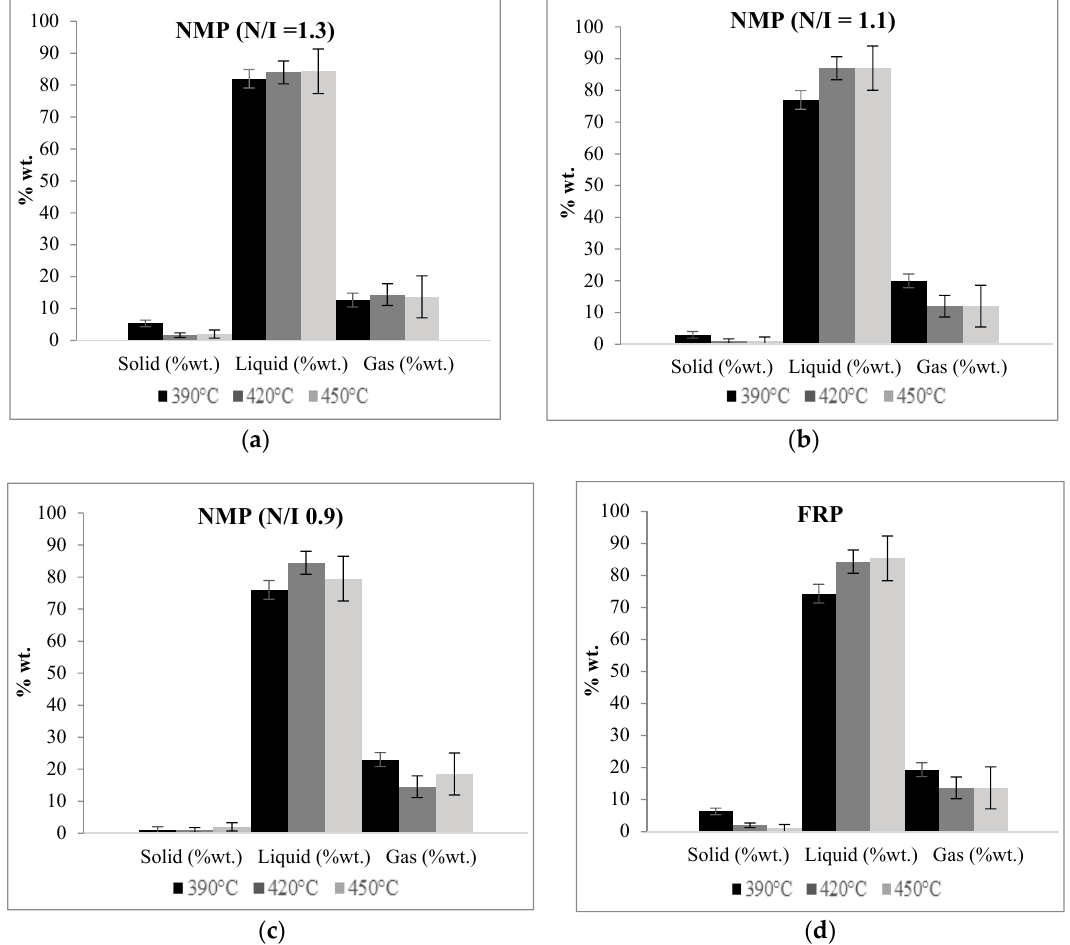
Figure 3. Yields of recovered fractions of the pyrolyzed samples: ( a ) N/I = 1.3, ( b ) N/I = 1.1, ( c ) N/I = 0.9, and ( d ) FRP.